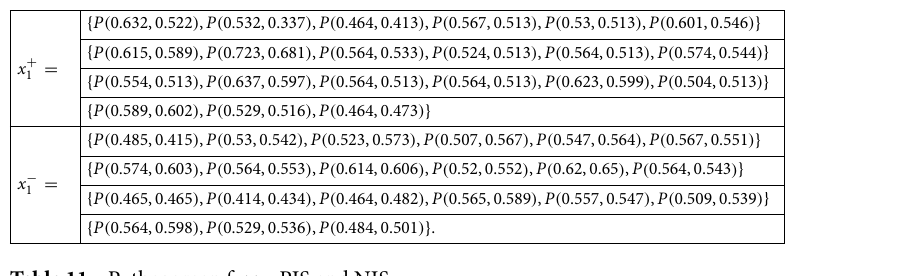
Table 11. Pythagorean fuzzy PIS and